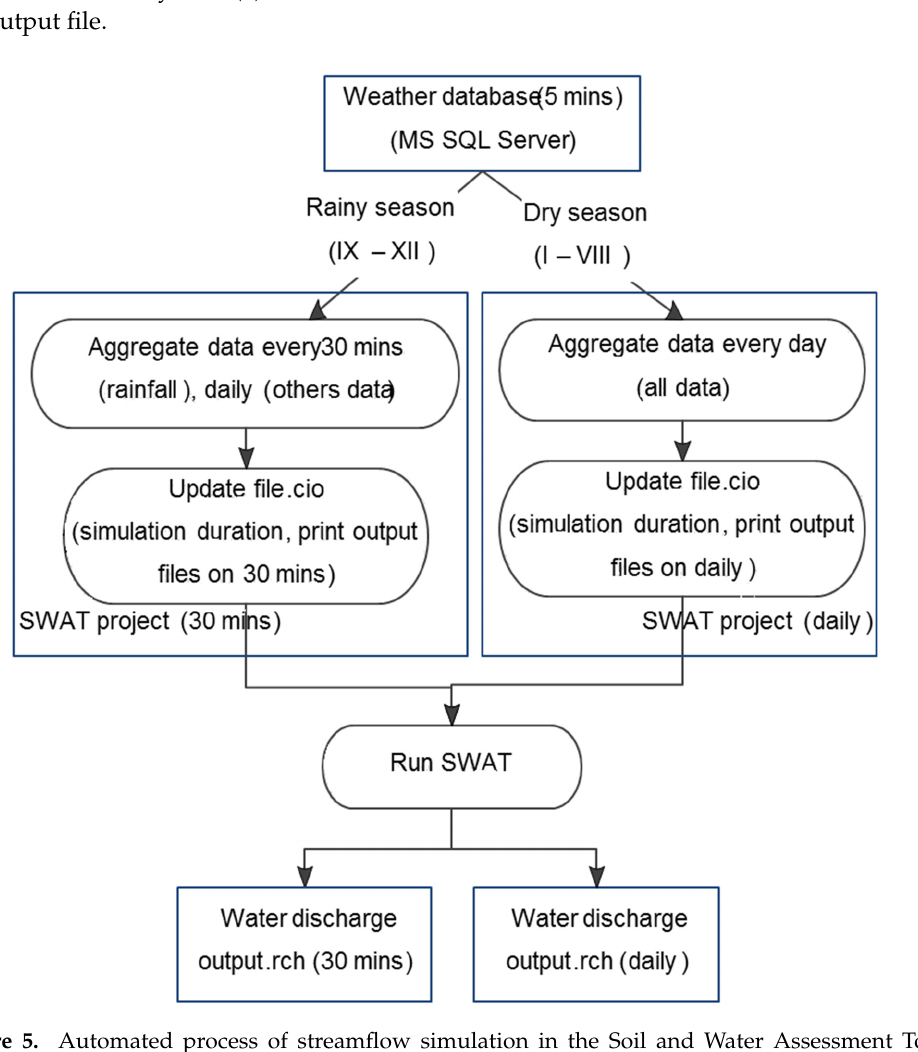
Figure 5. Automated process of streamflow simulation in the Soil and Water Assessment Tool (SWAT)